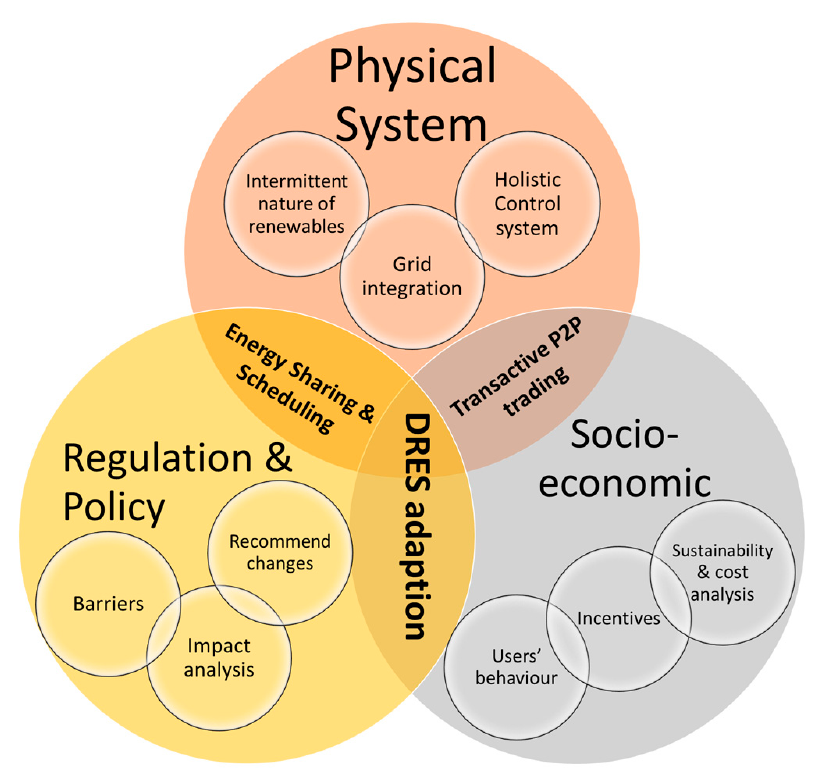
Figure 1. Multi-disciplinary nature of pathway to development and implementation of DRES within energy sector.